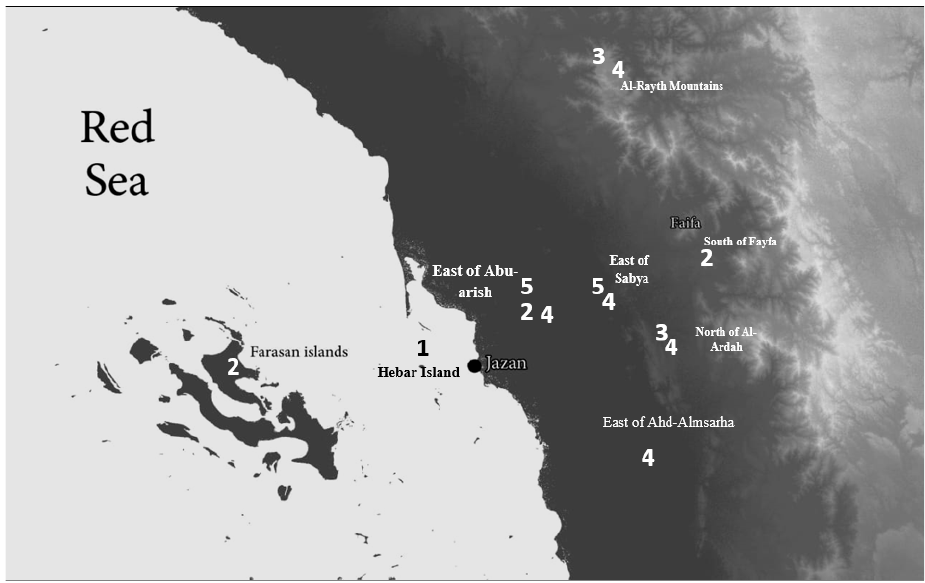
Figure 1. Study area map; numbers refer to the species (see Table 1). Table 1. The plant sample of Commiphora species collected from Jazan area with scientific and local names.